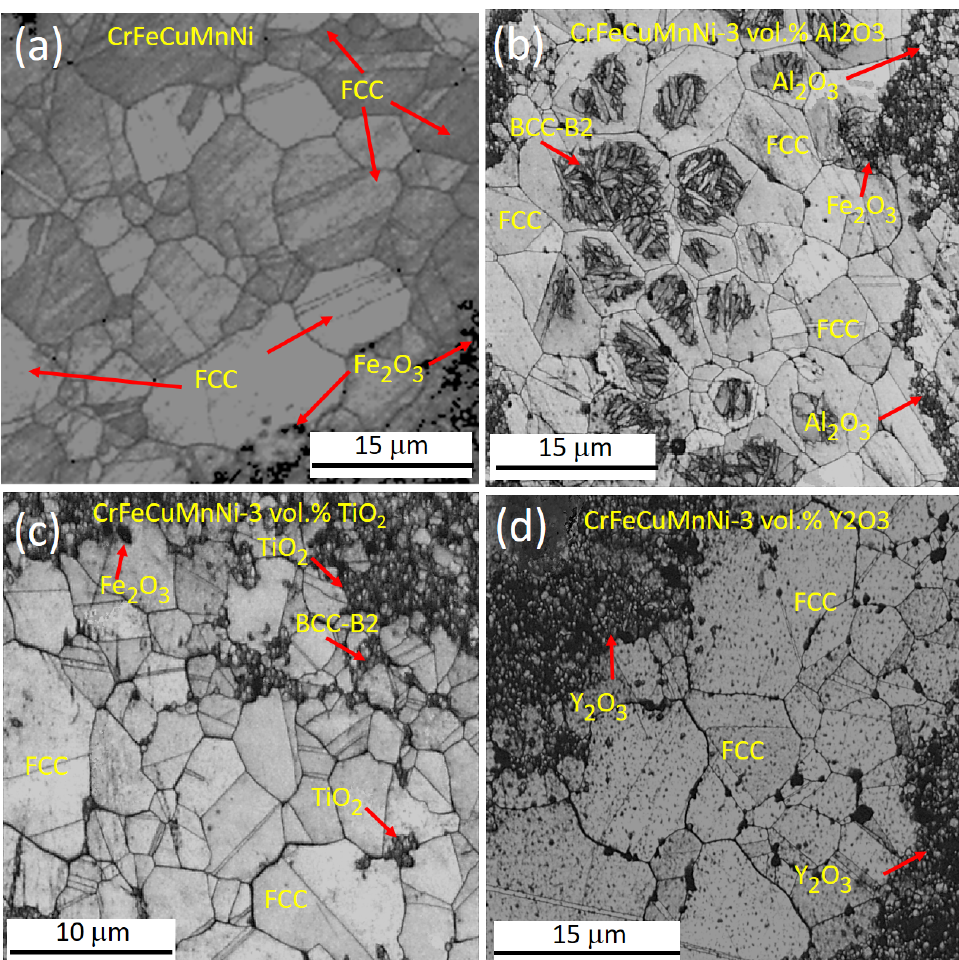
Figure 9. HRSEM microstructures of fabricated ODS-HECs: ( a ) CrFeCuMnNi; ( b ) CrFeCuMnNi-3 vol.% Al 2 O 3 ; ( c ) CrFeCuMnNi-3 vol.% TiO 2 ; and ( d ) CrFeCuMnNi-3 vol.% Y 2 O 3 .